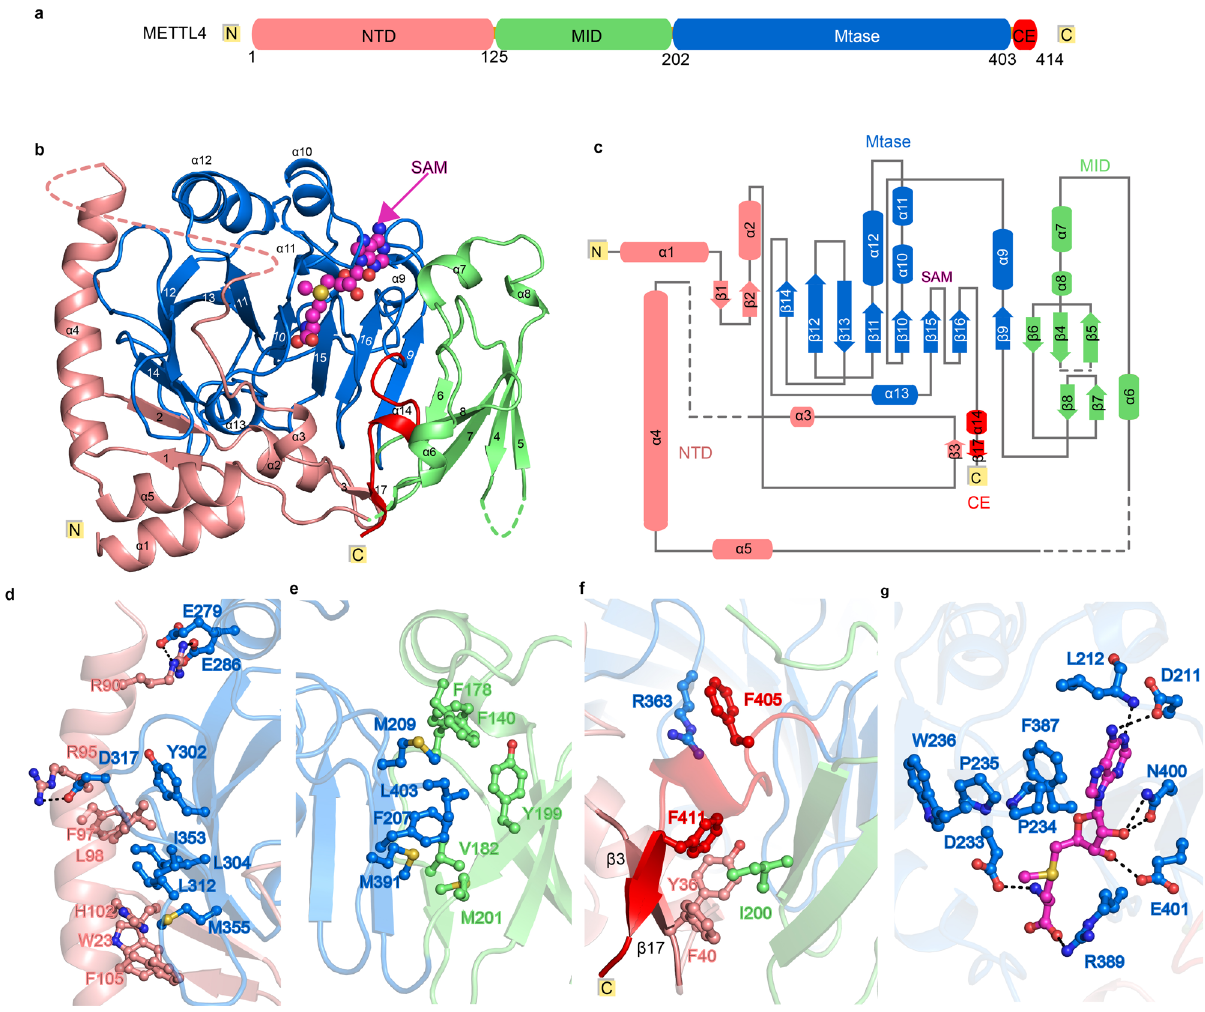
Fig. 2 | Crystal structure of full-length METTL4 bound to SAM. a Schematic domain structures of METTL4. b Cartoon representation of full-length METTL4 bound to SAM, with the β -strands and α -helices numbered numerically and the invisible residues in electric map shown as dashed lines. The SAM is shown as magenta sphere. c Schematic representation of the full-length structure of METTL4. d – f Close-up view of the interaction between MTase domain and NTD